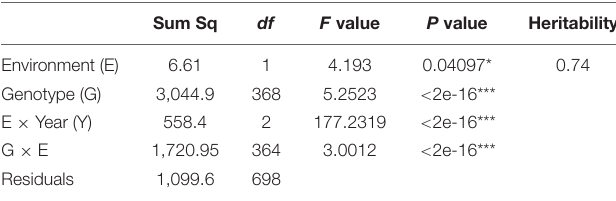
TABLE 2 | ANOVA for Septoria tritici blotch disease resistance in Septoria Association Mapping Panel (SAMP). Sum Sq df F value P value Heritability